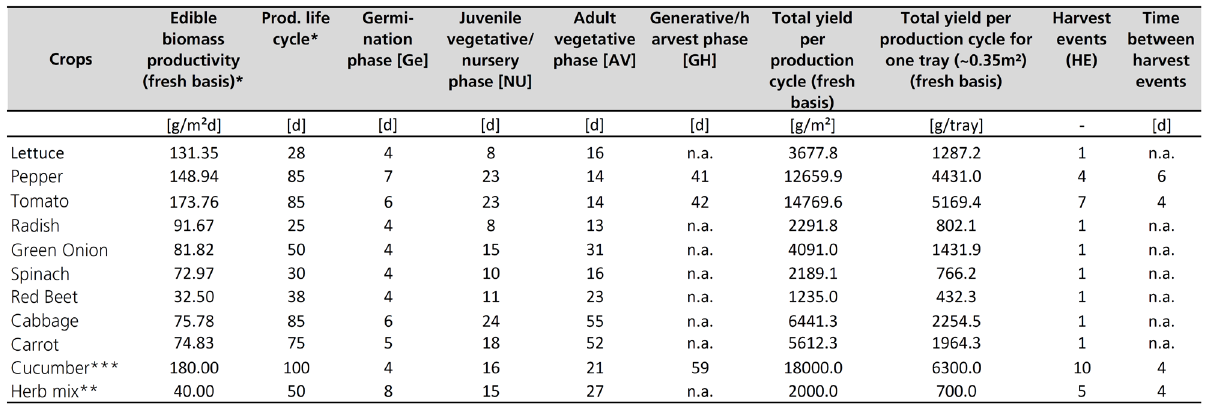
Table 3: Overview of production phases for target crops and harvest events with respective biomass output per crop tray. The harvest events were estimated according to best horticulture practices and expert opinon. For selective harvest biomass output values, please refer to Figure 4 for dedicated